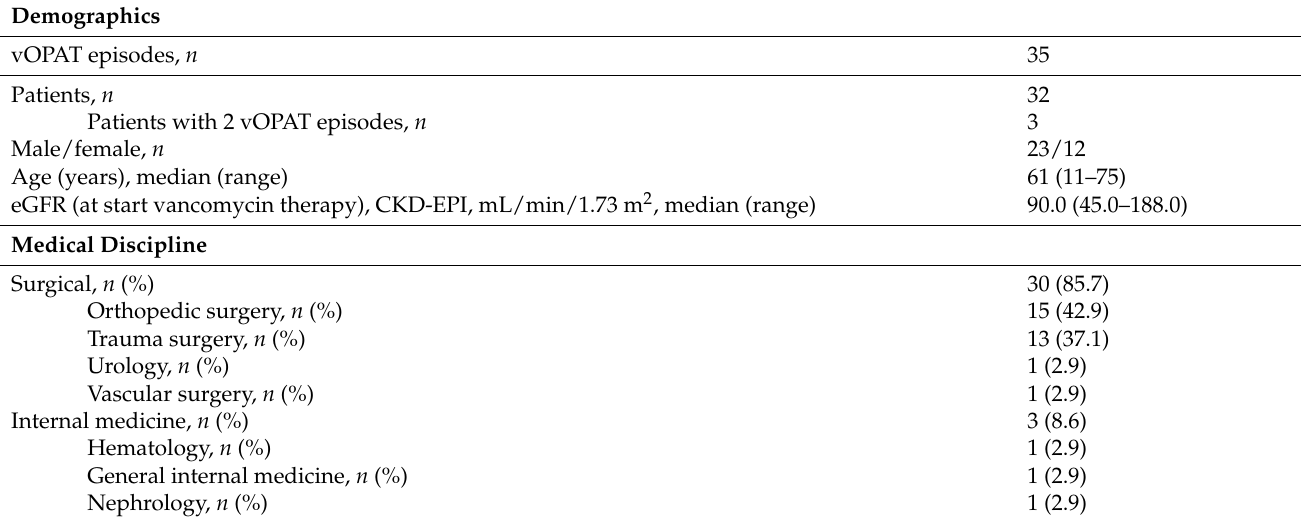
Table 3. Summary of demographic, clinical and treatment-related data of included vOPAT